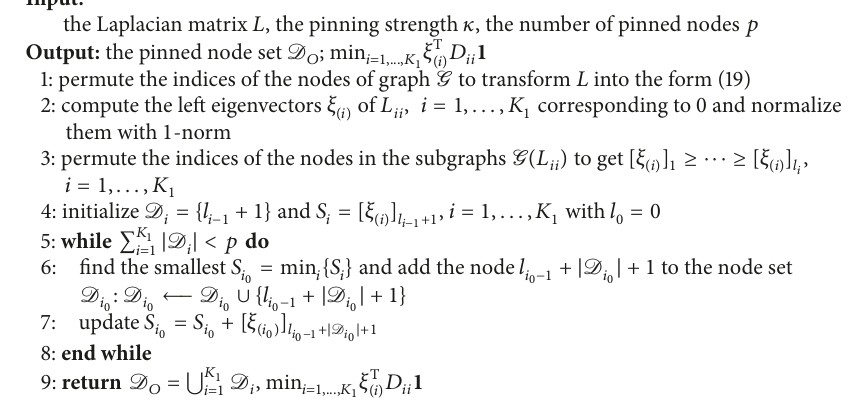
Algorithm 1: Searching for the pinned node set D 𝑂 that maximizes min 𝑖=1,...,𝐾